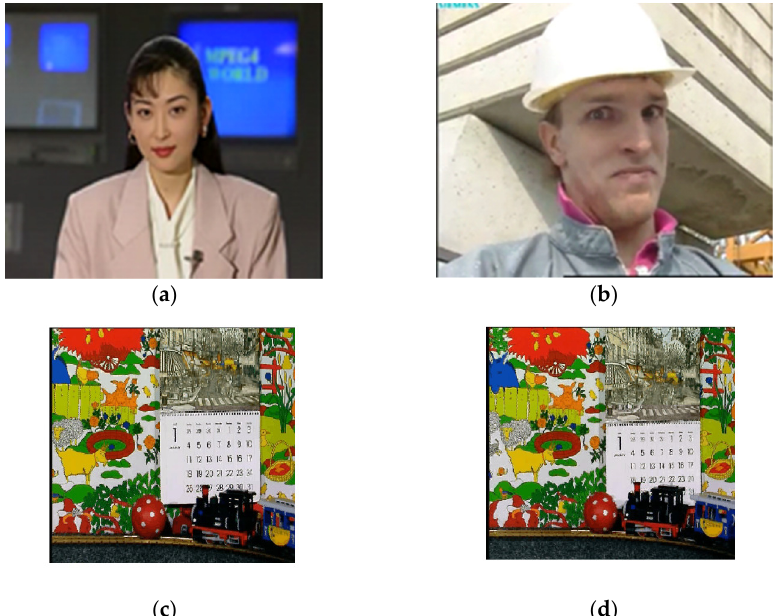
Figure 6. ( a ) Akiyo. ( b ) Foreman. ( c , d ) Mobile. ( c , d ) Snapshots of the two scenes of the video clip.